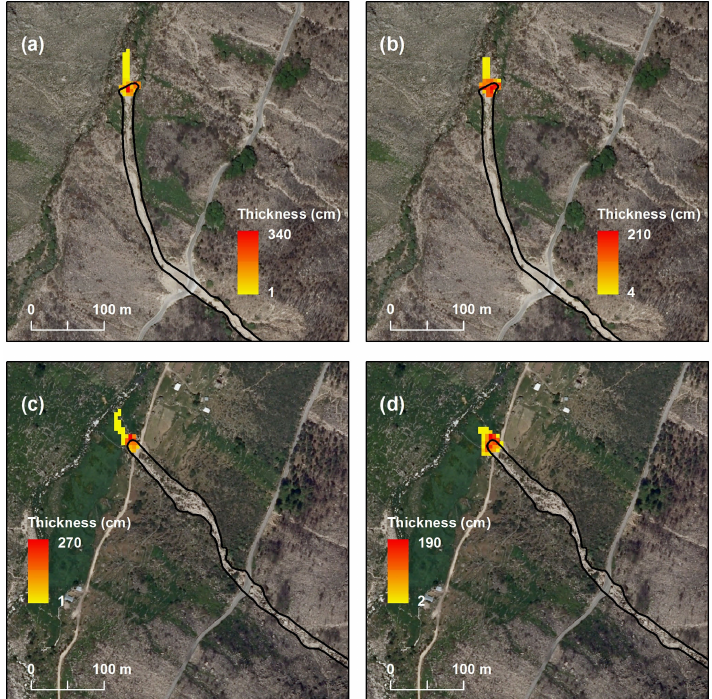
Figure 6. DF#1 and DF#2 modeling with the Coulomb frictional (a, c) and with the Voellmy (b, d) models.